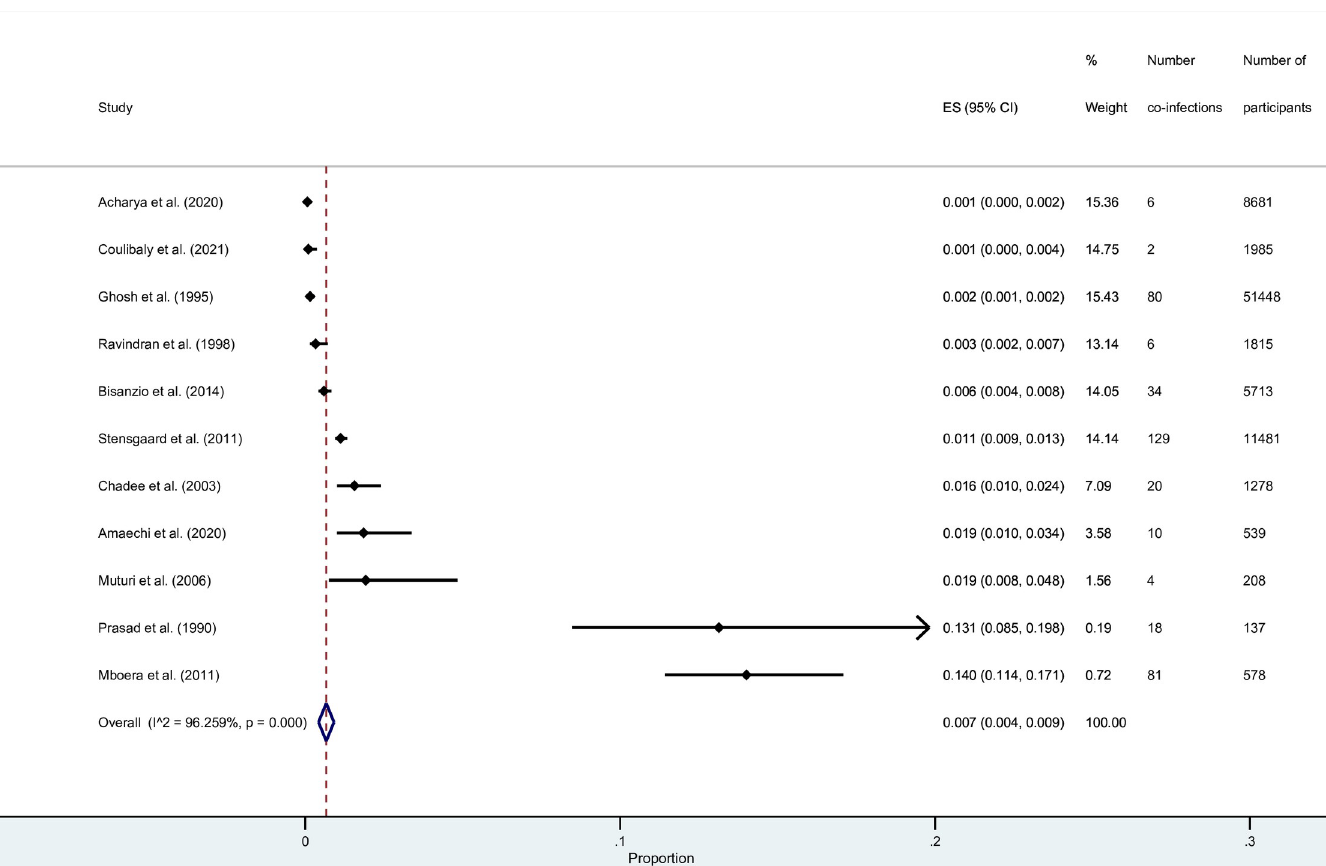
Fig 4. The prevalence of malaria and Wuchereria bancrofti co-infections among selected studies. Abbreviations : ES- prevalence estimate; CI:- confidence interval.